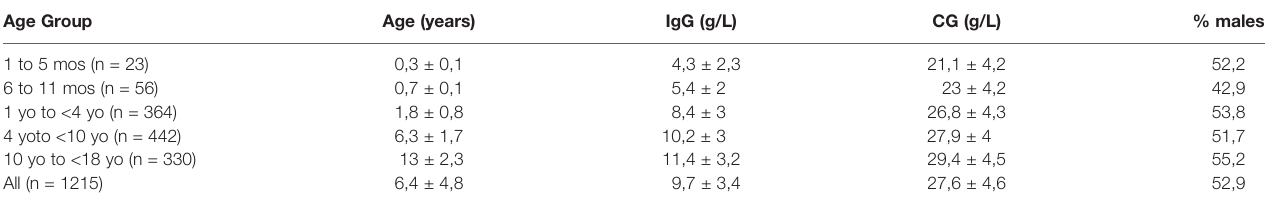
TABLE 1 | Characteristics of patients studied for the IgG vs CG correlation a . Age Group